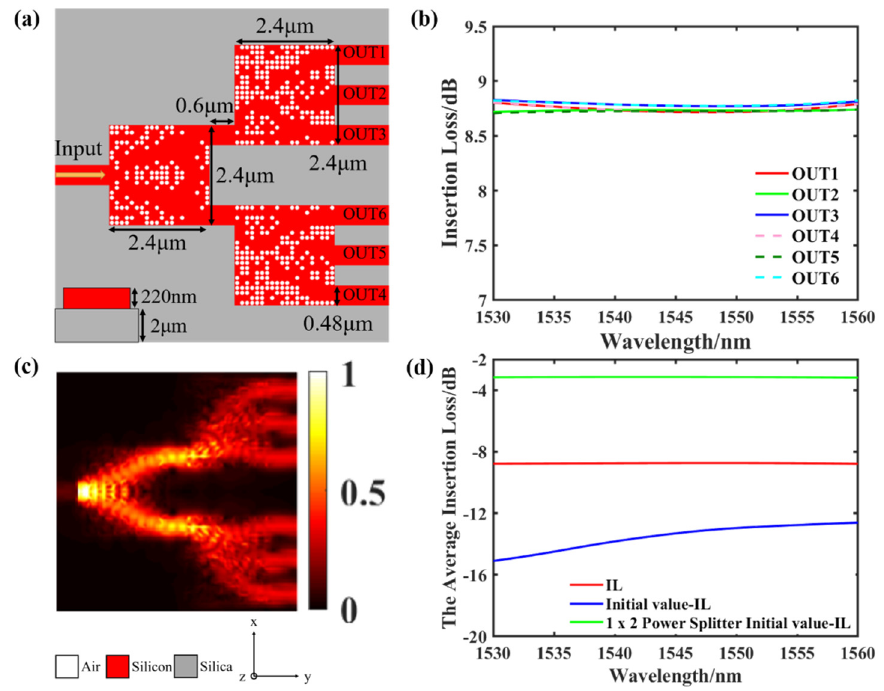
Figure 5. The simulated results of 1 × 6 power splitter. ( a ) The final structure after optimization. ( b ) are the IL of each port. ( c ) Simulated optical field distributions. ( d ) The 1 × 2 power splitter’s average insertion loss after initial IL and simple combination was compared with the average insertion loss after further optimization. Table 1. Comparison of other works.